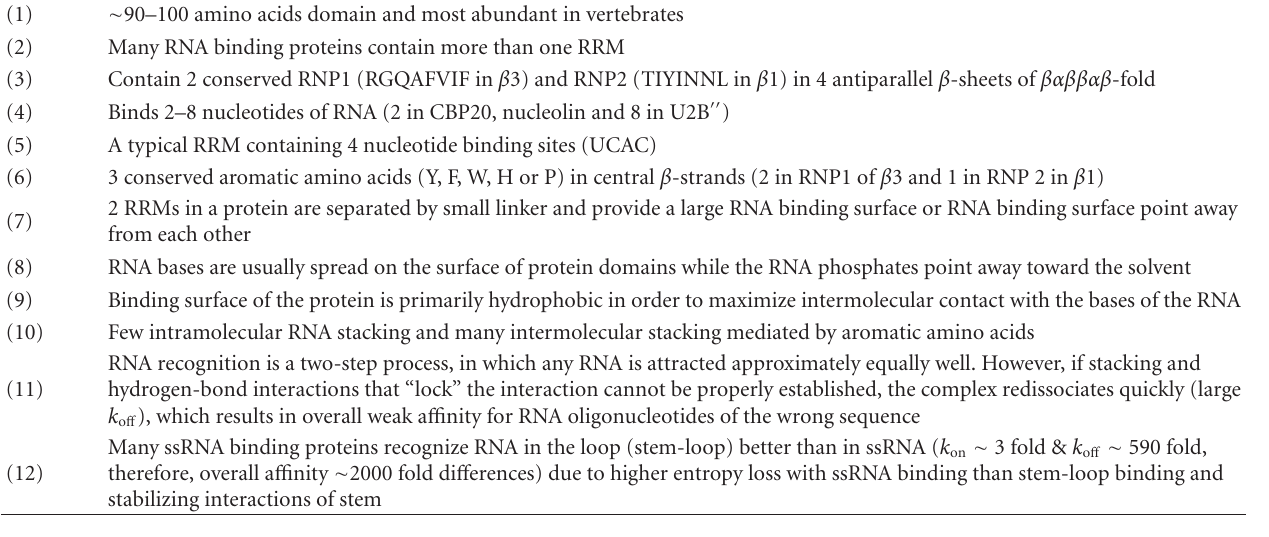
Figure 2: Polyacrylamide gel electrophoretic separations of nuclear 4–7S RNAs of rat liver and Noviko ff hepatoma cells [7]. (a) The 8% gel electrophoretic patterns of 4–7S RNA from various cell organelles of rat liver. The gel was stained with methylene blue for RNA visualization. (1) Nuclear 4–7S RNA, (2) ribosomal 4–7S RNA, (3) mitochondrial 4–7S RNA, and (4) soluble cytoplasmic sap 4–7S RNA. (b) The 10% slab polyacrylamide gel electrophoretic separation of [ 32 P]-labeled 4–7S RNA from Noviko ff hepatoma cell nuclei. The gel was autographed with X-ray film. Table 2: Characteristics of RRM/RNP/RBD